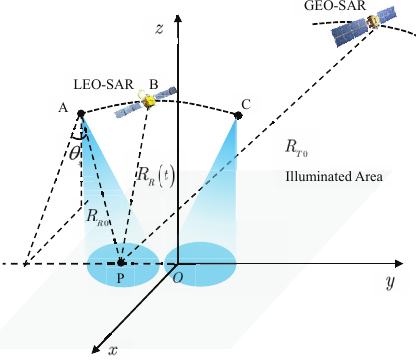
Figure 1. Imaging geometry of GEO-LEO BiSAR in